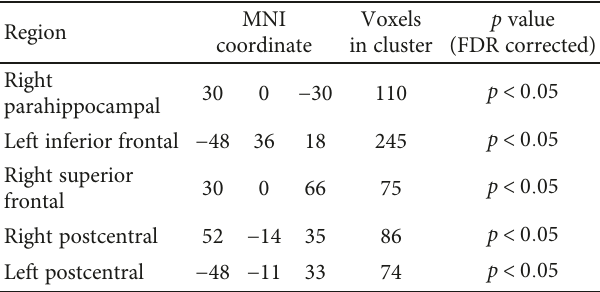
Figure 2: Di ff erence of the activation pattern between presurgery and postsurgery. Areas including the bilateral postcentral gyrus, right parahippocampal, left inferior frontal lobe, and right superior frontal lobe show signi fi cantly decreased activation after surgery. Table 2: Paired t- test results of activation pattern of sensory stimulus task between presurgery and postsurgery.